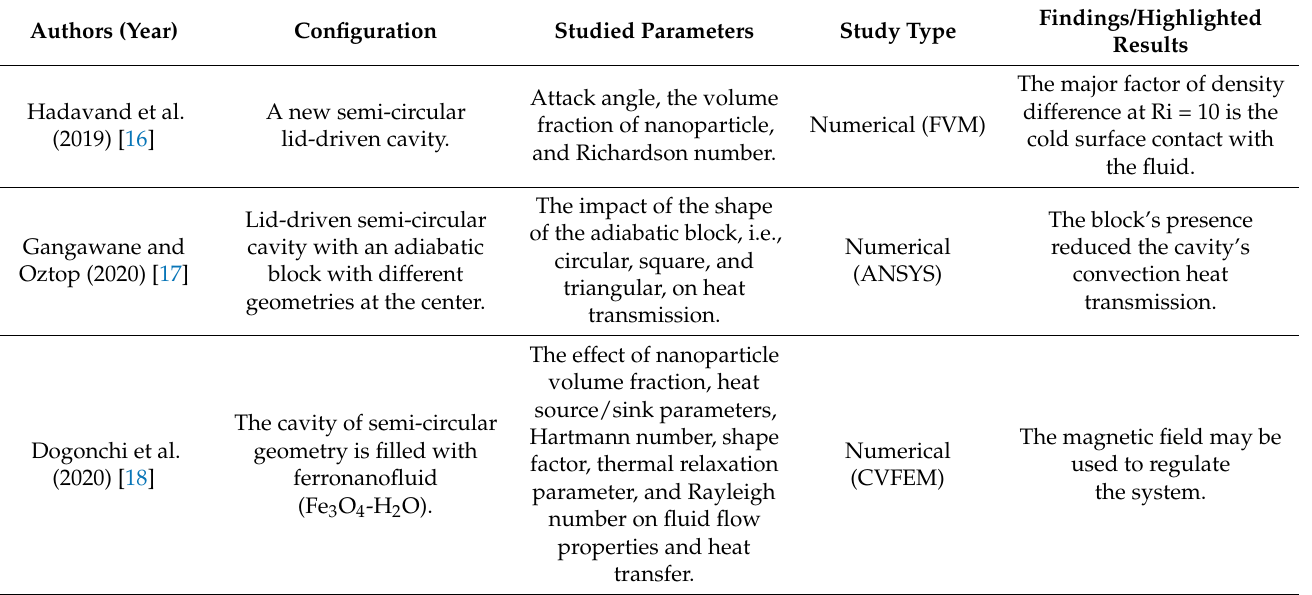
Figure 7. Variation of Rayleigh number with the total stress for the distortion of the movable plate ( left ) and movable plate ( right ) under steady-state conditions. Reprinted with permission from Ref. [21]. 2021, Elsevier. Table 1 presents a summary of review on circular cavities. Table 1. summary of review on circular cavities.